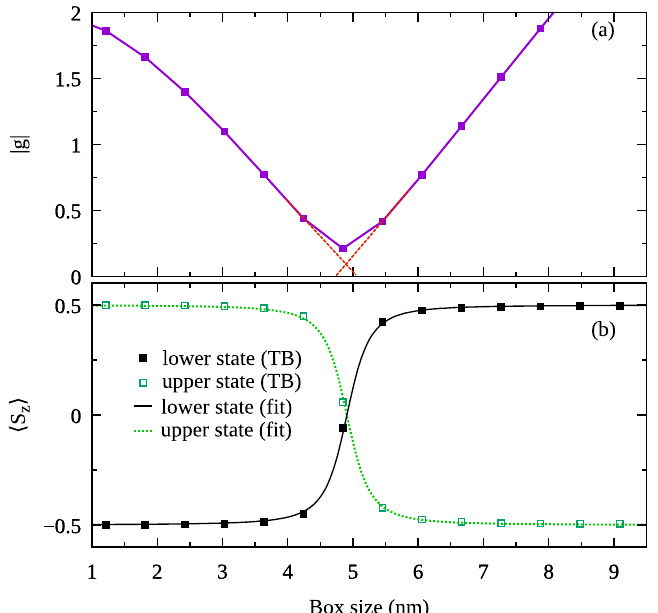
Figure 5. (Color online) ( a ) The absolute value of the electron (conduction band) g-factor in a mixed-anion- cation-terminated InAs cubic box of C 1 symmetry. The red dashed lines are a guide for eye. ( b ) Average value of the spin z -th component for the states in the Zeeman